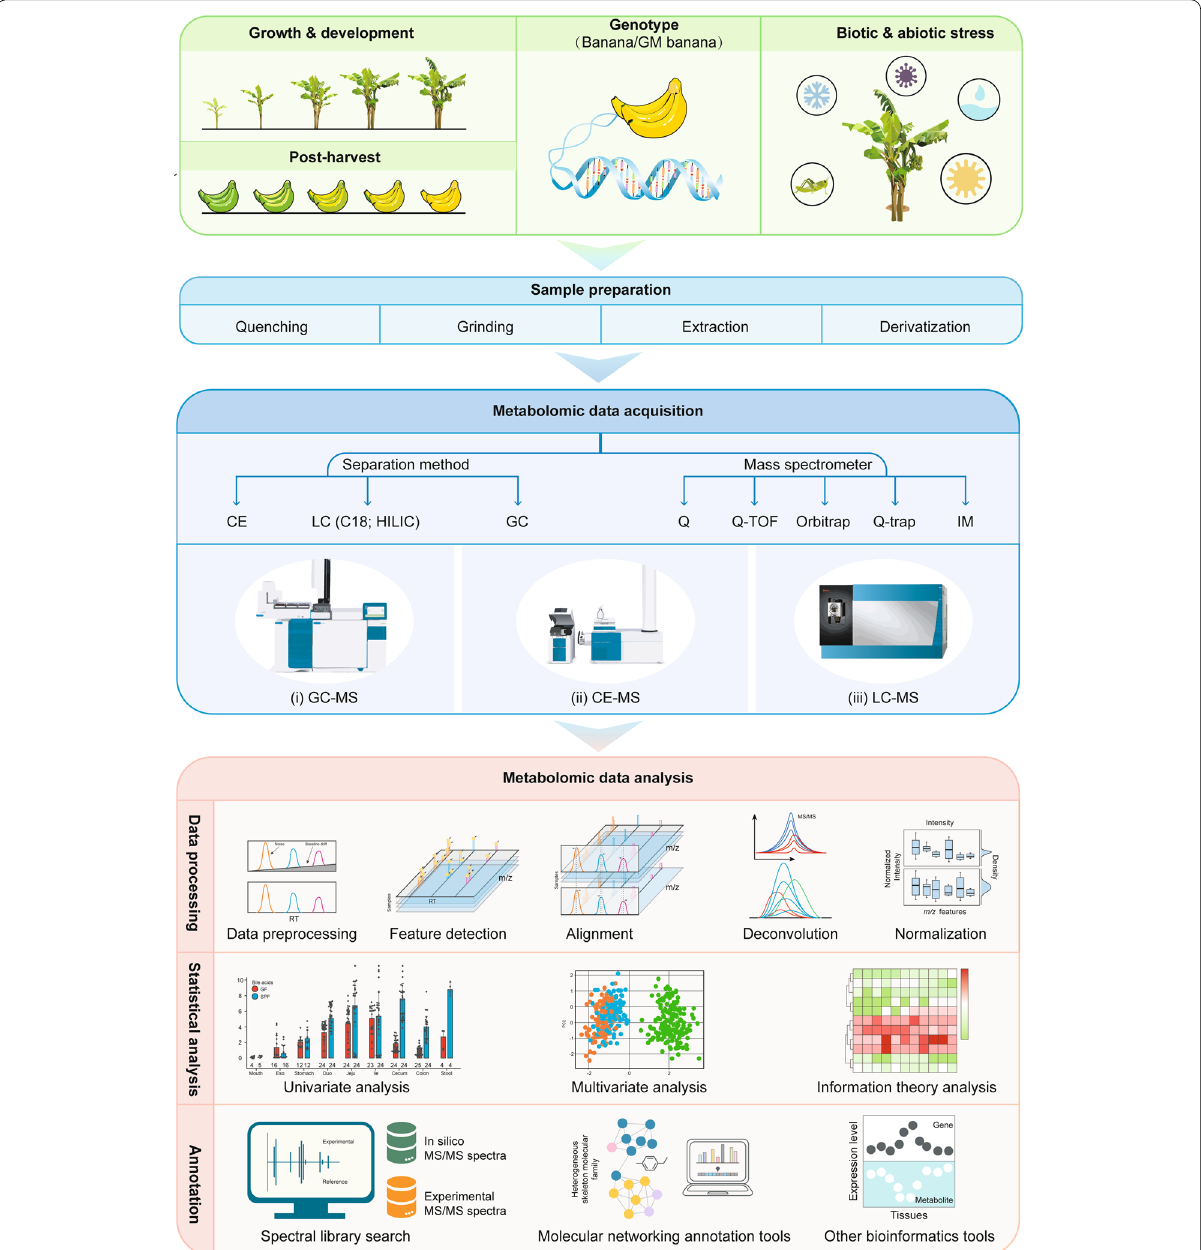
Fig. 4 A general workflow for MS-based plant metabolomics study, including experimental design, sample preparation, metabolomic data acquisition, and metabolomic data